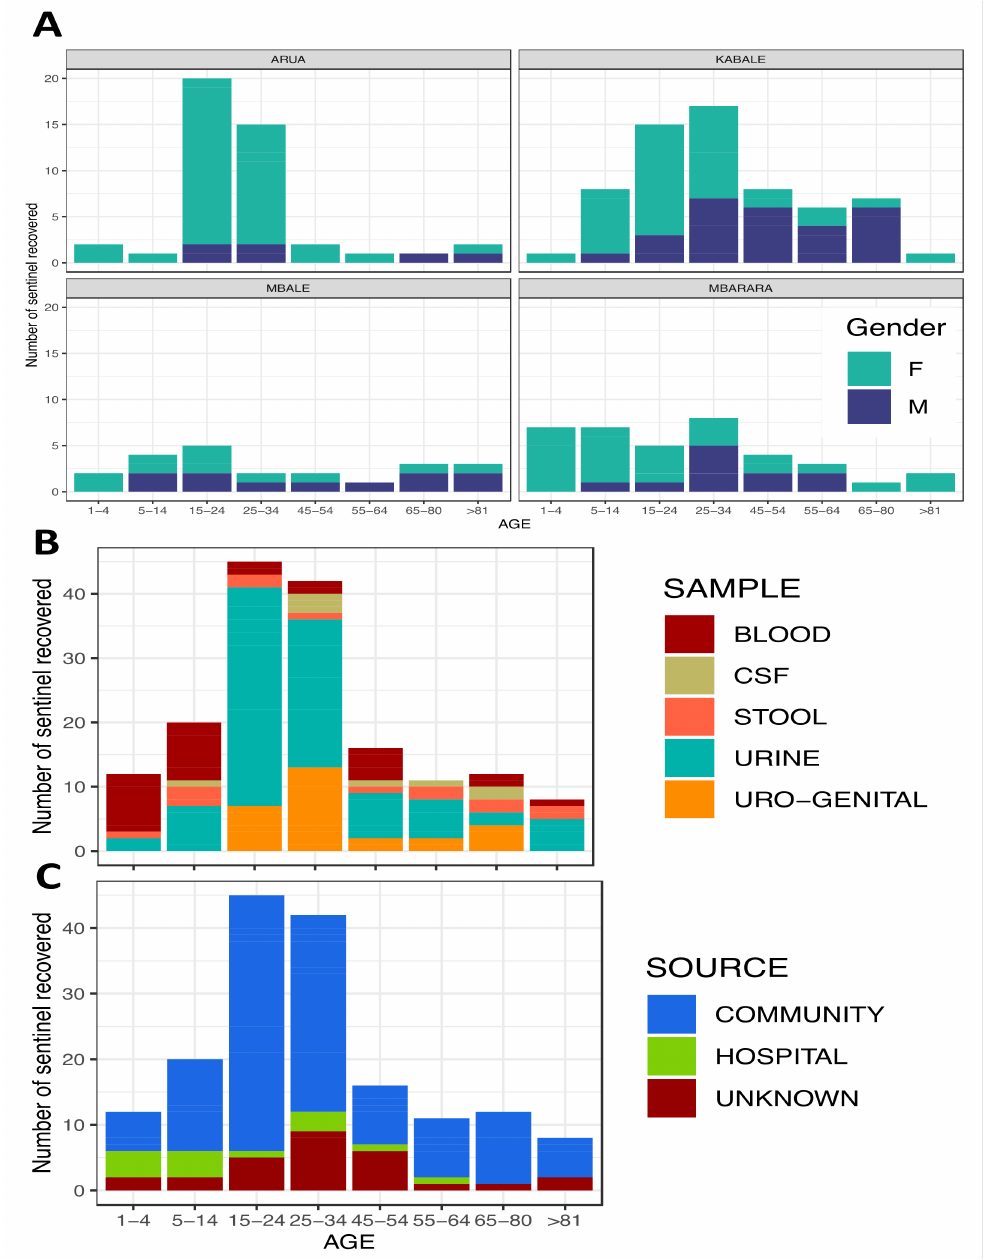
Figure 6. Preliminary analysis of microbes recovered from specific samples. ( A ) shows the distri- bution of these organisms by district, age group and gender. ( B , C ) show the same distribution by specimen collected and source, i.e., community or